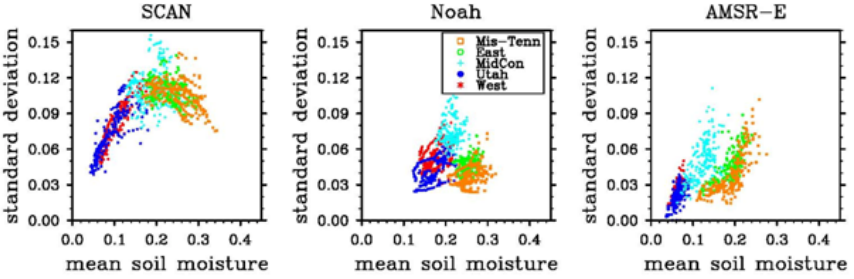
Fig. 3. Spatial variability (standard deviation) of soil moisture as a function of mean soil moisture (cm 3 cm − 3 ) for the three data types. Statistics of Noah and AMSR-E were calculated using data at SCAN locations.